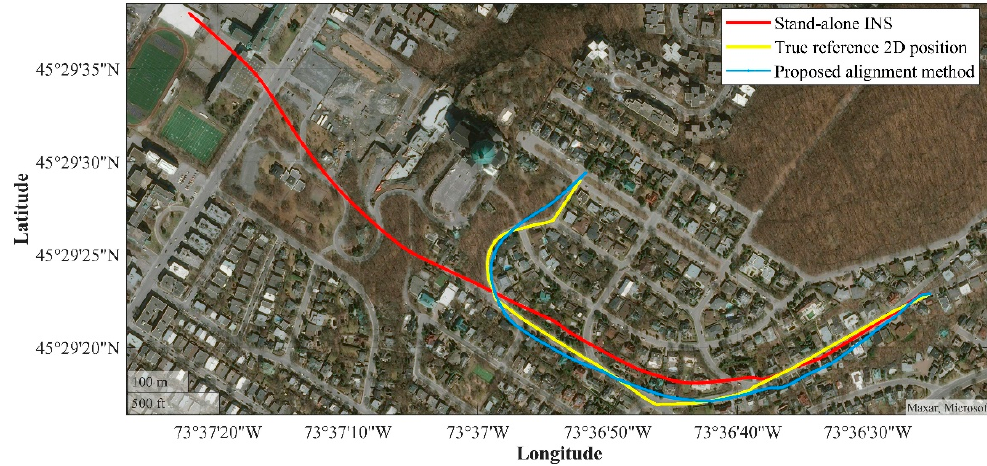
Figure 14. The estimated trajectory of the vehicle compared to the stand-alone INS and the true reference position.